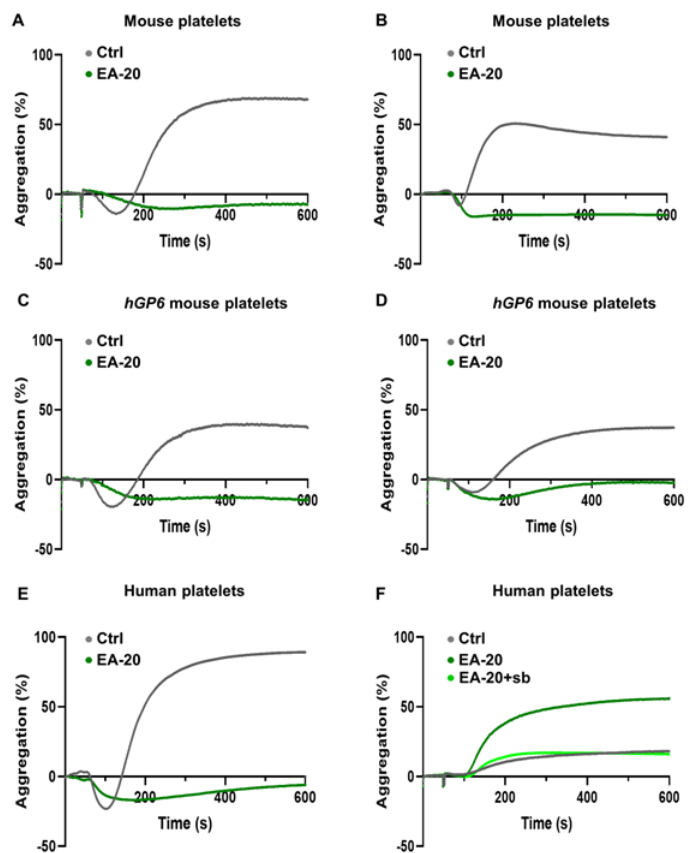
Figure 4. EA-20 antibody impairs aggregation of mouse and human platelets in response to Col-I and CRP. Washed mouse and human platelets were stimulated with Col-I ( A , C , E Col-I 2.5 µg/mL) and CRP ( B , D CRP 0.2 µg/mL and F CRP 0.4 µg/mL) in the presence of control IgG (Ctrl) or EA-20 antibody. Experiments were performed using ( A , B ) WT mouse, ( C , D ) humanized GPVI ( hGP6 ) mouse, and ( E , F ) human platelets; sb: seroblock. Platelet aggregation was measured using light transmission aggregometry and recorded for 10 min. Representative aggregation curves are